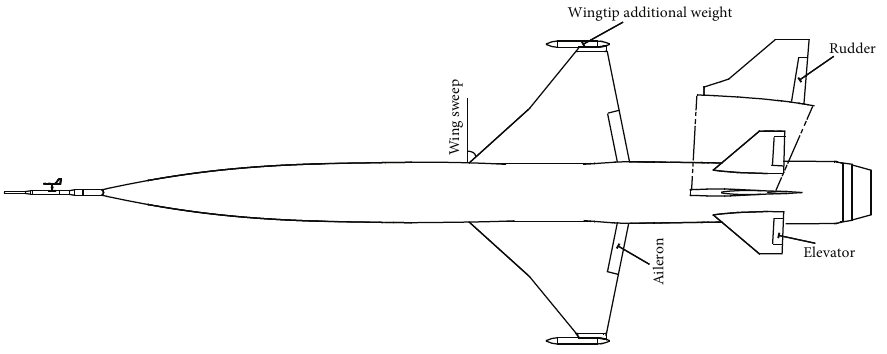
Figure 1: Plan view of the research LSR